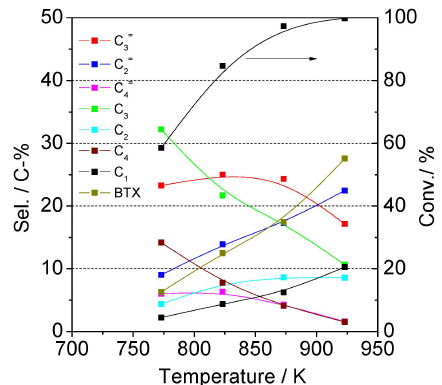
Figure 11. Effect of reaction temperature on the catalytic cracking of n -hexane for HB(12) catalyst. Reaction conditions: Cat., 0.1 g; P n- hexane = 6 kPa; W / F n- hexane = 64 g h/mol; temperature 773–923 K, TOS = 15 min. Products abbreviations: propylene (C 3= ); ethylene (C 2= ); butenes (C 4= ); propane (C 3 ); ethane (C 2 ); butanes (C 4 ); methane (C 1 ); benzene, toluene and xylene (BTX).